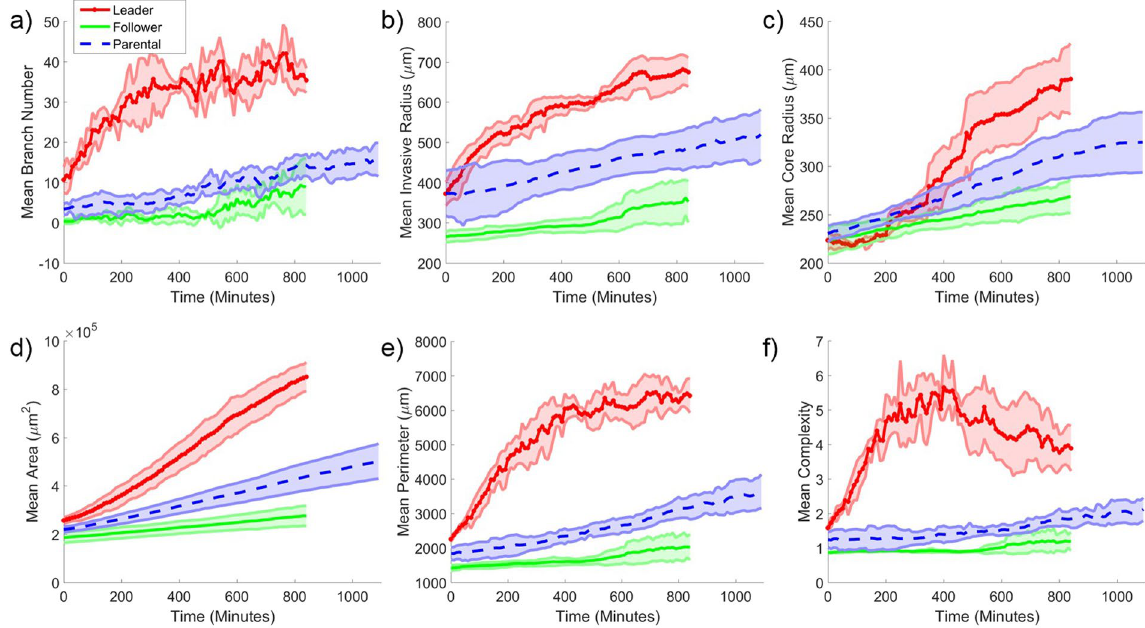
Figure 4. Visualization of average dynamic features under different treatments. Average values for ( a ) branch number, ( b ) invasive radius, ( c ) core radius, ( d ) area, ( e ) perimeter and ( f ) complexity as a function of time for different cell lines. Red solid lines with x symbols represent mean values for leader spheroids. Shaded areas represent 95% confidence intervals for feature values over the